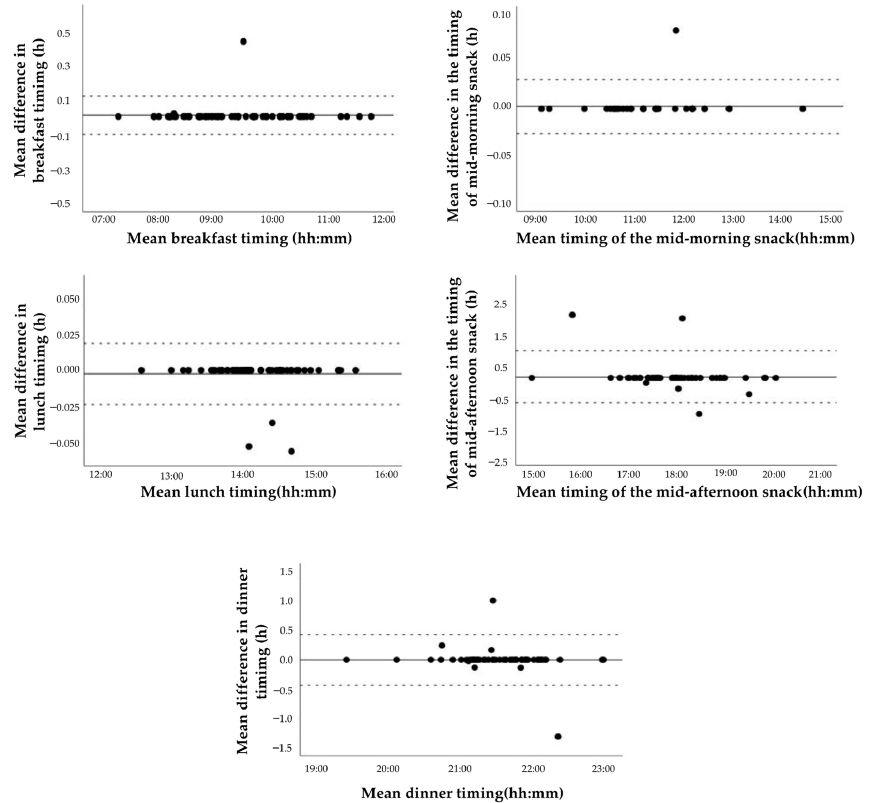
Figure 3. Bland–Altman plots showing mean difference vs. mean timing (solid line) between the test (Remind app) and reference (3-day handwritten food records) methods, and the lower and upper limits of agreement (dotted lines) for breakfast, mid-morning snack, lunch, mid-afternoon snack, and dinner